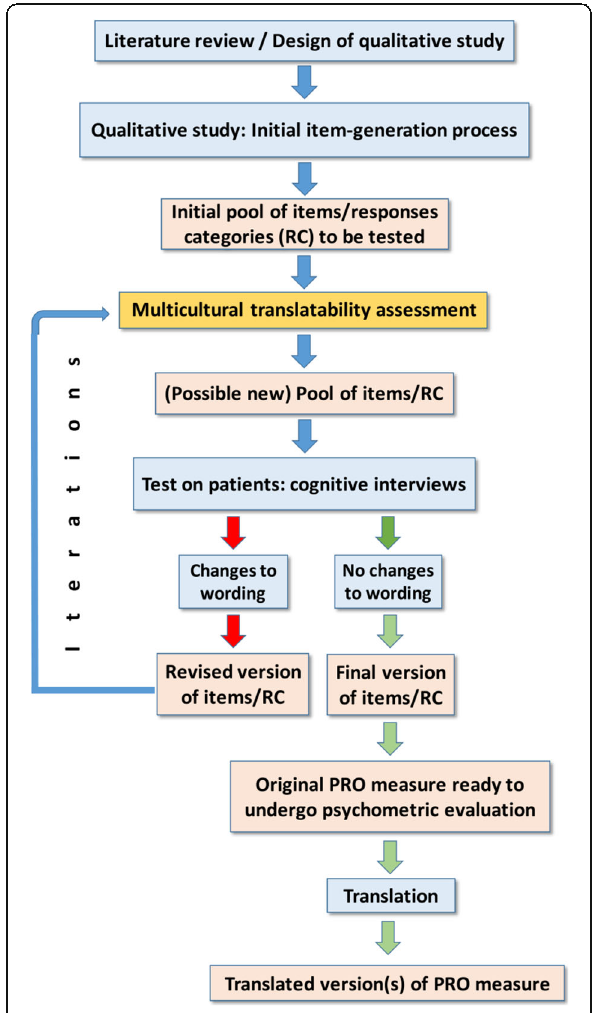
Fig. 1 Timing of TA during PRO measure